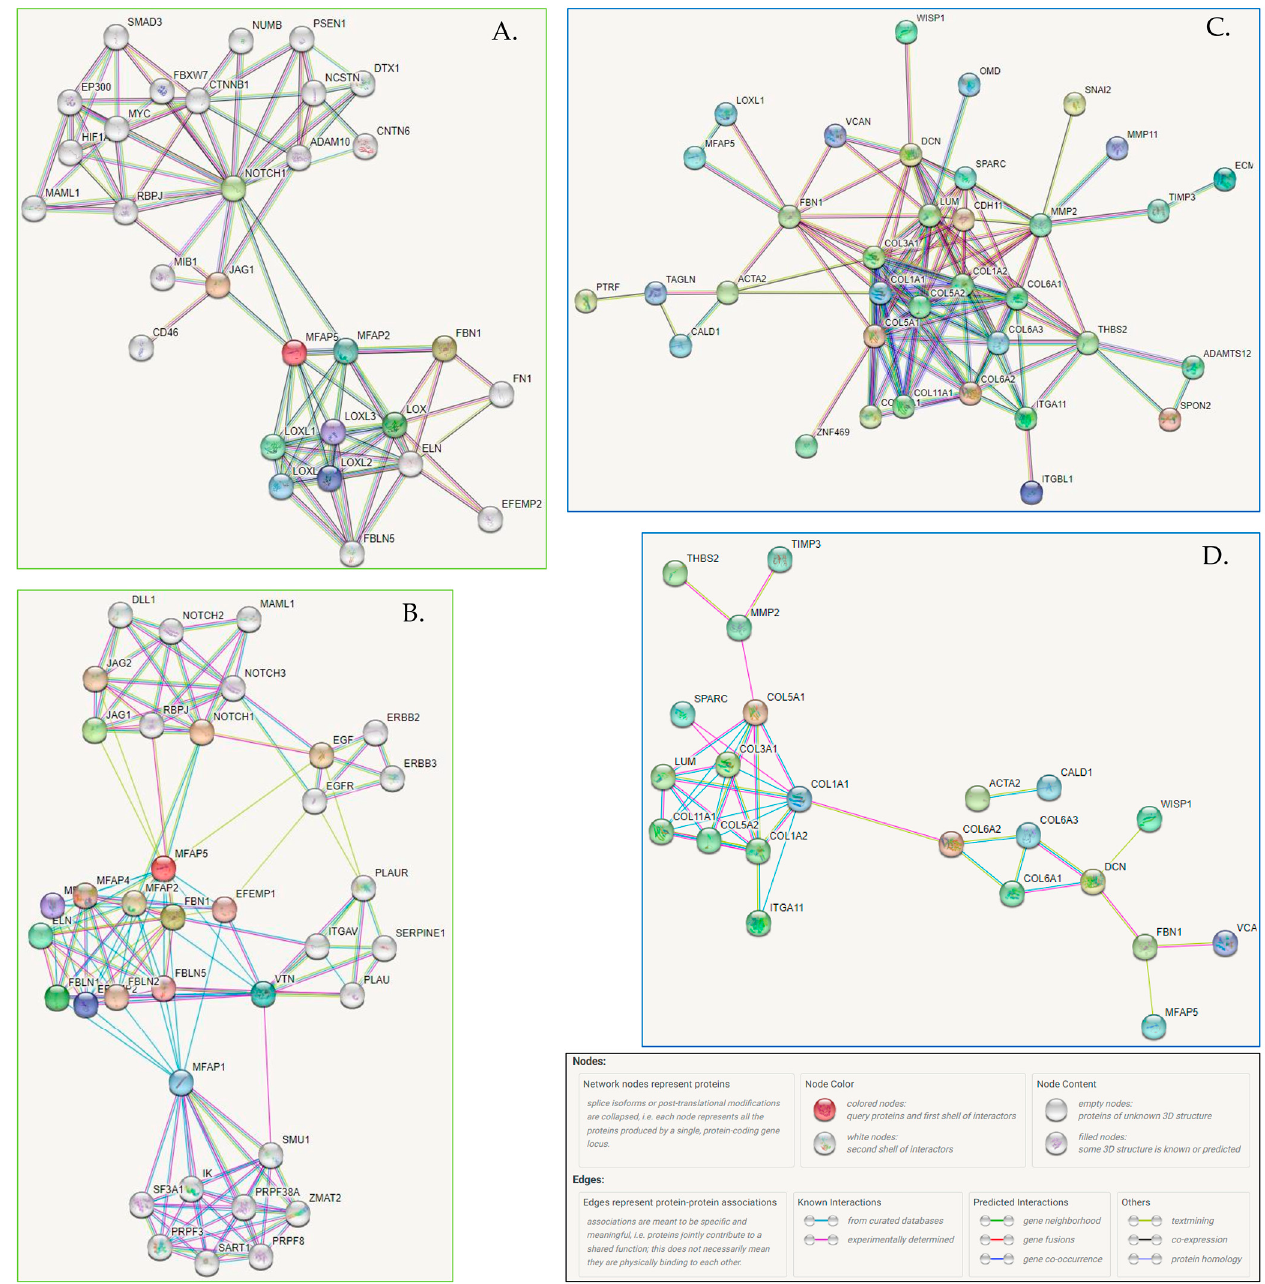
Figure 6. ( A , B ) The association network for MFAP5 protein generated by the STRING (v11.5) algo ‐ rithm. ( A ) STRING settings: full network, all interaction sources (textmining, experiments, data ‐ bases), first shell—max. 50 interactions, second shell—max. 20 interactions, the cutoff for showing interaction links set to highest confidence (0.900). Edges indicate both functional and physical pro ‐ tein associations; line colors indicate the type of evidence for a given interaction. (https://version ‐ 11 ‐ 5.string ‐ db.org/cgi/network?networkId=bxczNZBaRpdh; accessed on 10 June 22). ( B ) STRING settings: physical interactions (edges indicate that proteins are part of the same physical complex, but not necessarily directly interacting), line color indicates the type of interaction evidence, inter ‐ action sources: textmining, experiments, databases; first shell—max. 50 interactions, second shell— max. 20 interactions, the cutoff for showing interaction links set to medium confidence (0.400). (https://version ‐ 11 ‐ 5.string ‐ db.org/cgi/network?networkId=bevdGiCGDLZV; accessed on 10 June 22). ( C , D ) Functional and physical protein associations of MFAP5 and co ‐ expressed proteins. ( C ) STRING settings: input—71 co ‐ expressed genes (cBioPortal) and MFAP5; full network; all interac ‐ tion sources (textmining, experiments, databases); first shell—none, second shell—none; the cutoff